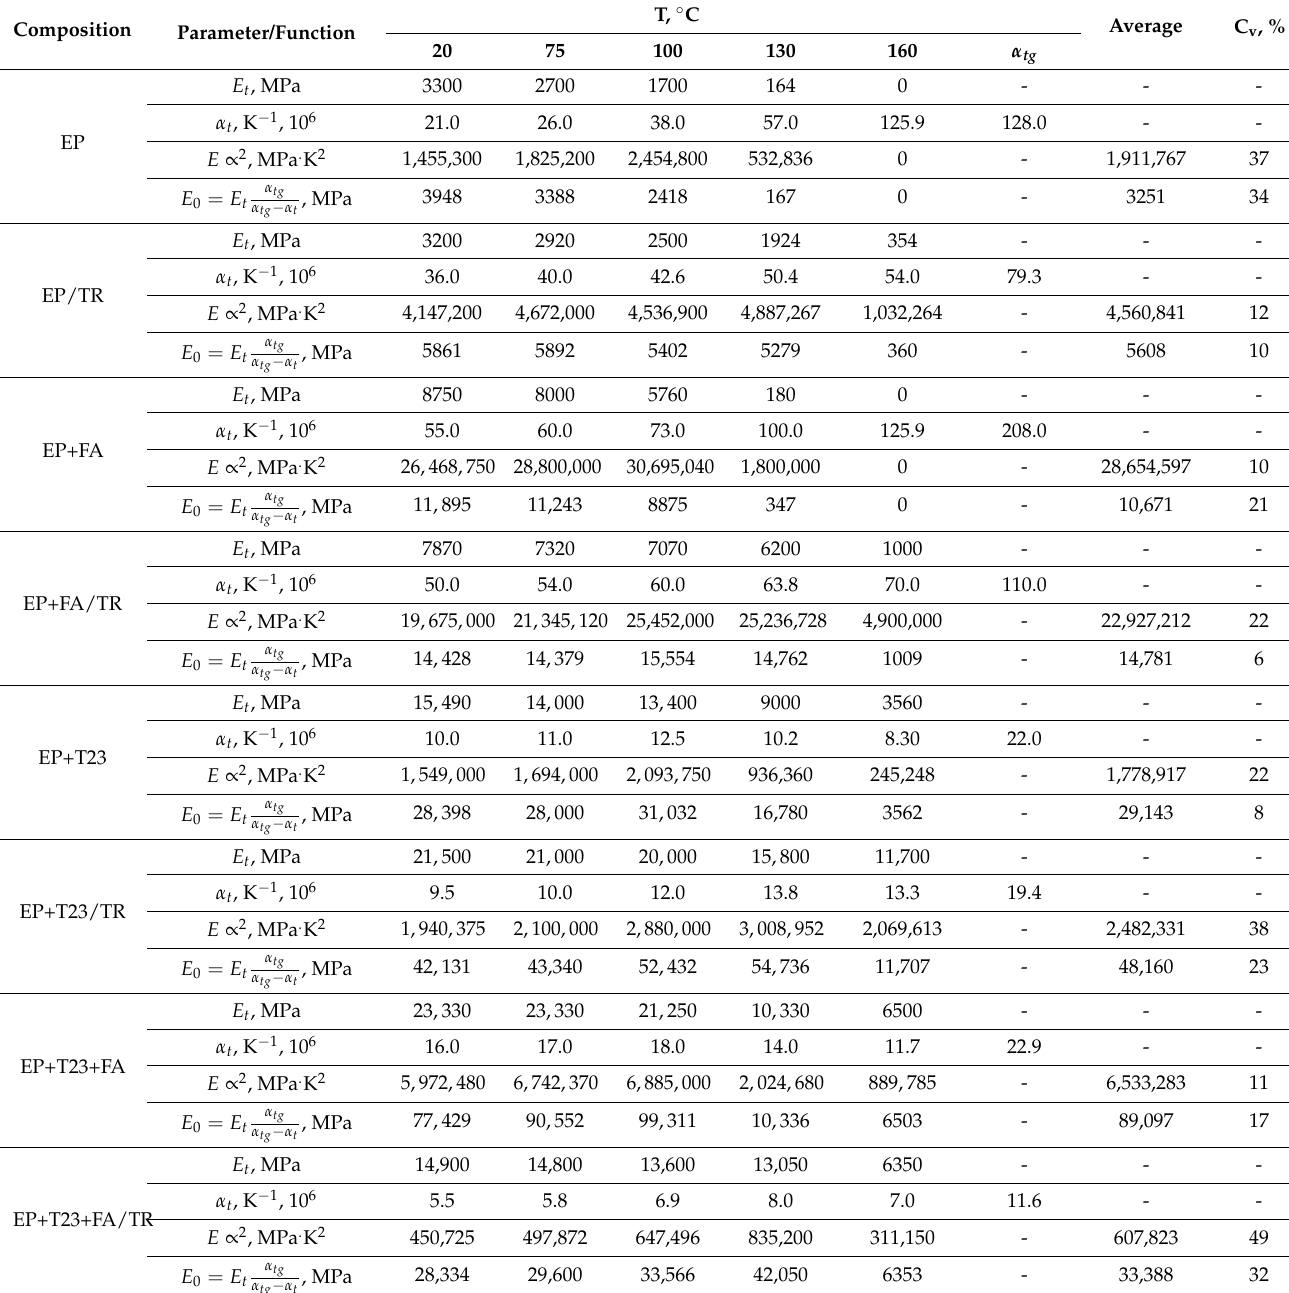
Table 2. Results of calculation of MoE-CTE relation models’ parameters and agreement degrees.